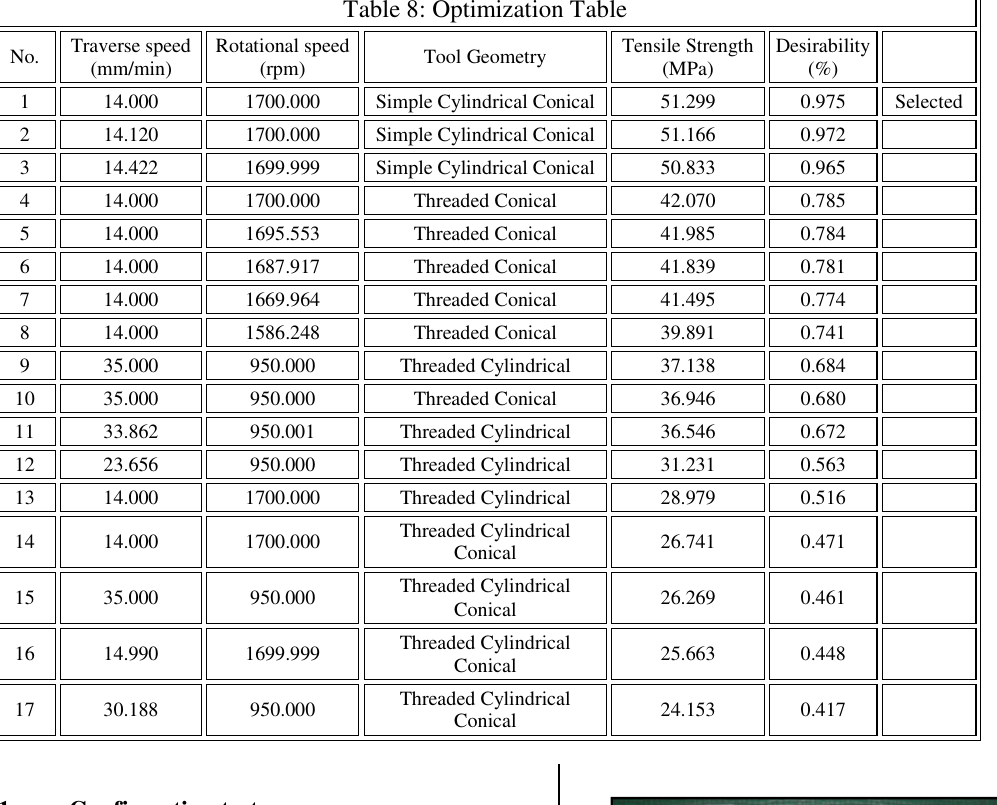
Table 8: Optimization Table